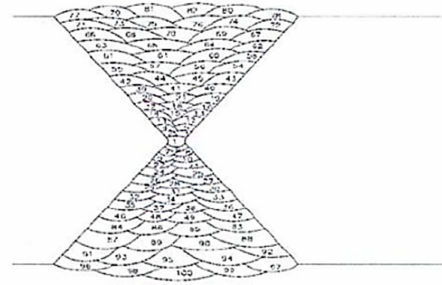
Figure 3. Multiple passes of the X-shape Shielded Metal Arc Welding (SMAW) weld.